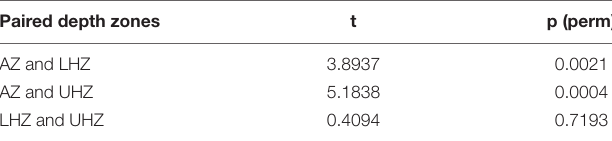
TABLE 4 | Pairwise comparisons in PERMDISP among SUs from AZ ( < 6,000 m), UHZ (6,000–6,500 m), and LHZ ( > 6,500 m) in the Yap